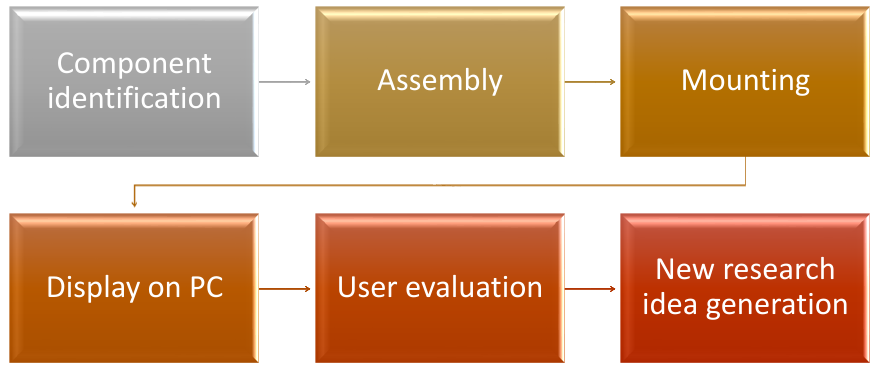
Figure 2. Research method block diagram.